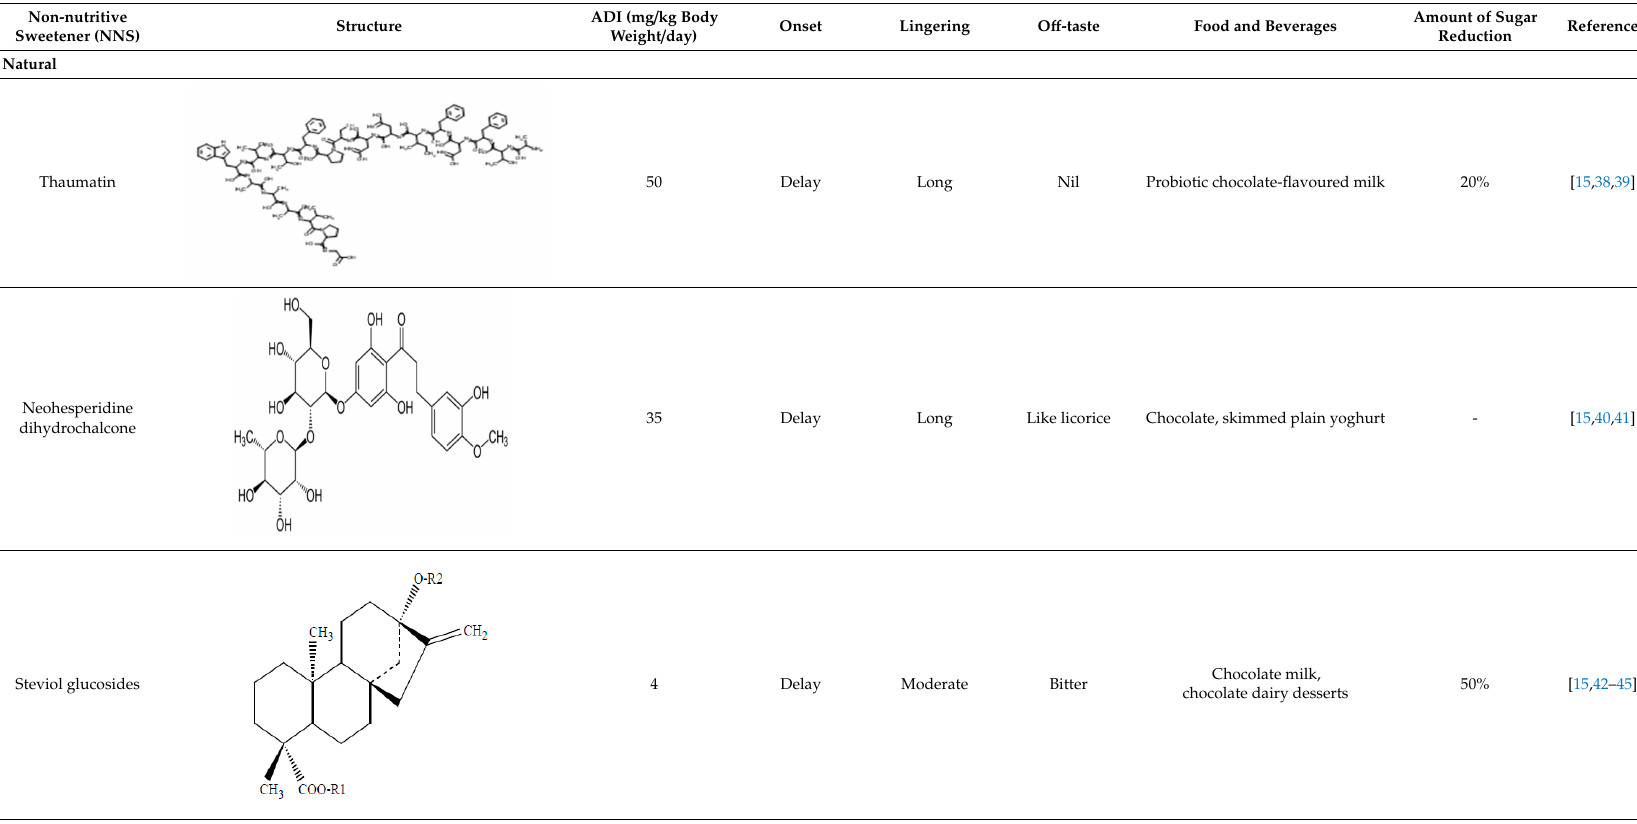
Table 1. Natural and artificial non-nutritive sweeteners (NNSs) used for sugar reduction in dairy products.